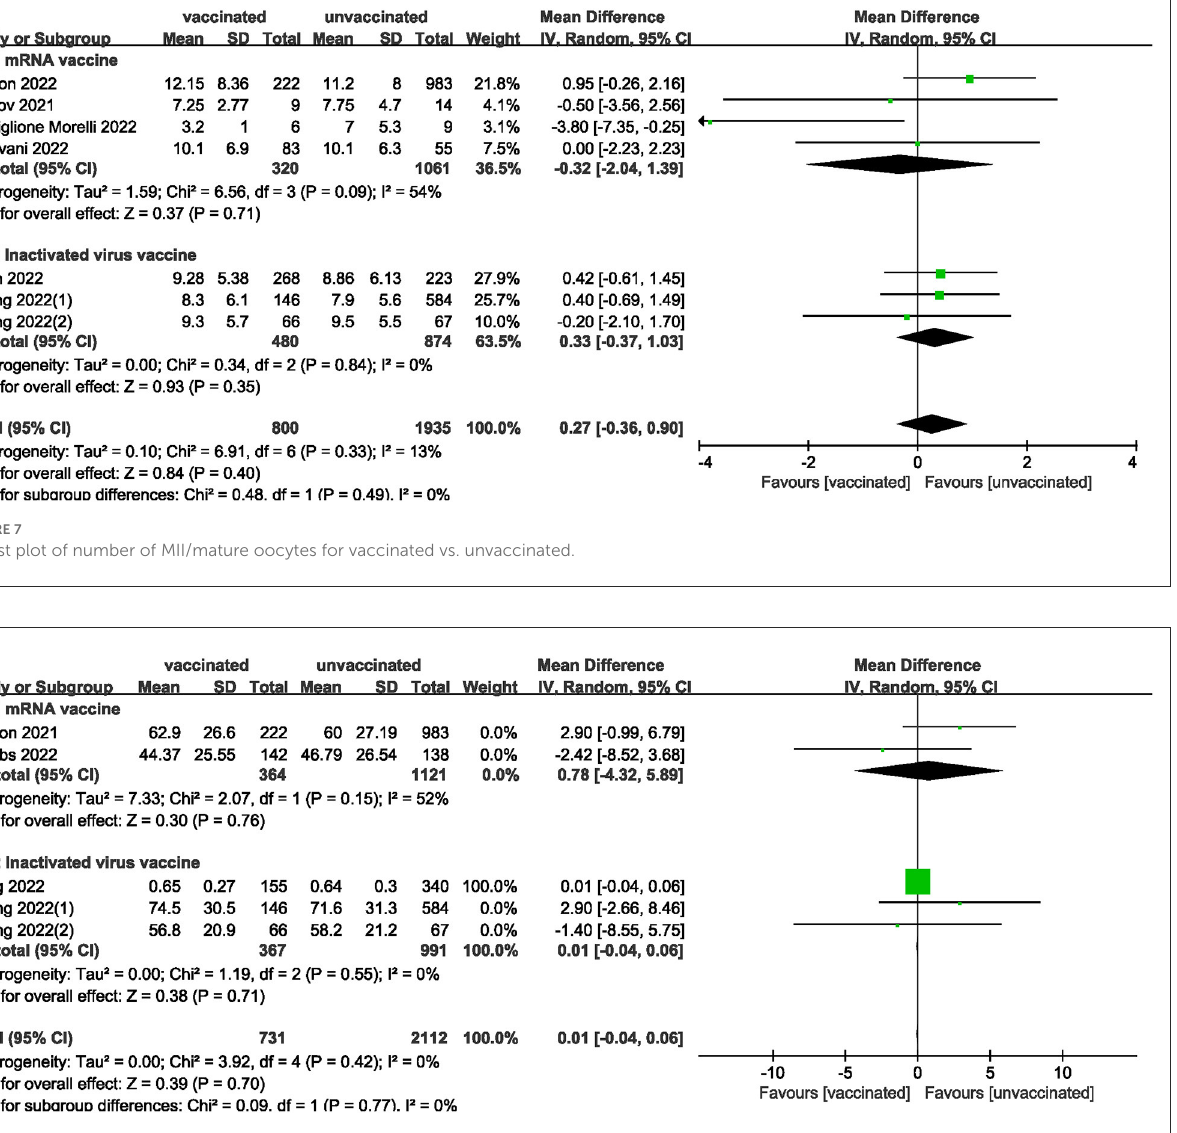
FIGURE8 Forest plot of blastocysts rate for vaccinated vs.